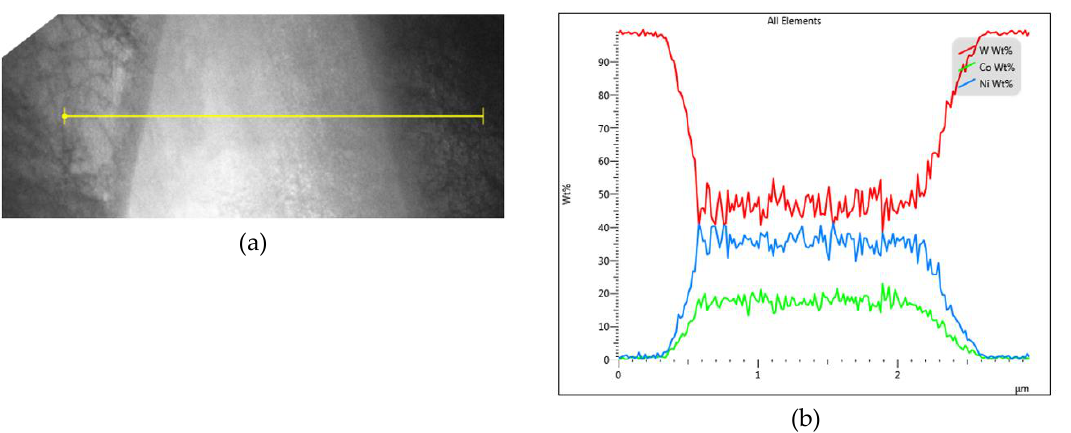
Figure 5. TEM scan showing a W-NiCo-W interface and measured line scan area for sample sintered at 1500 °C for 180 min ( a ); chemical composition of measured line scan ( b ).